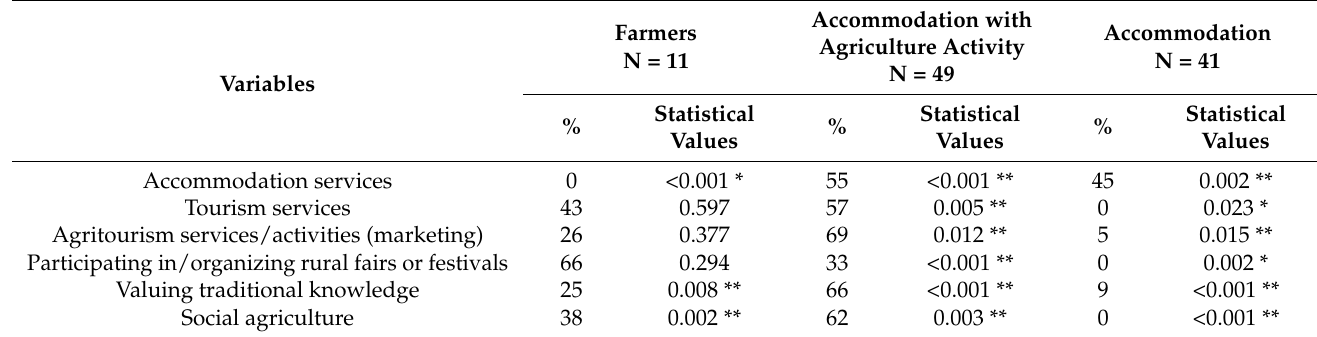
Table 10. A comparison of social variables between accommodation and other entrepreneurial agritourism models (Chi-square analysis of dummy variables).